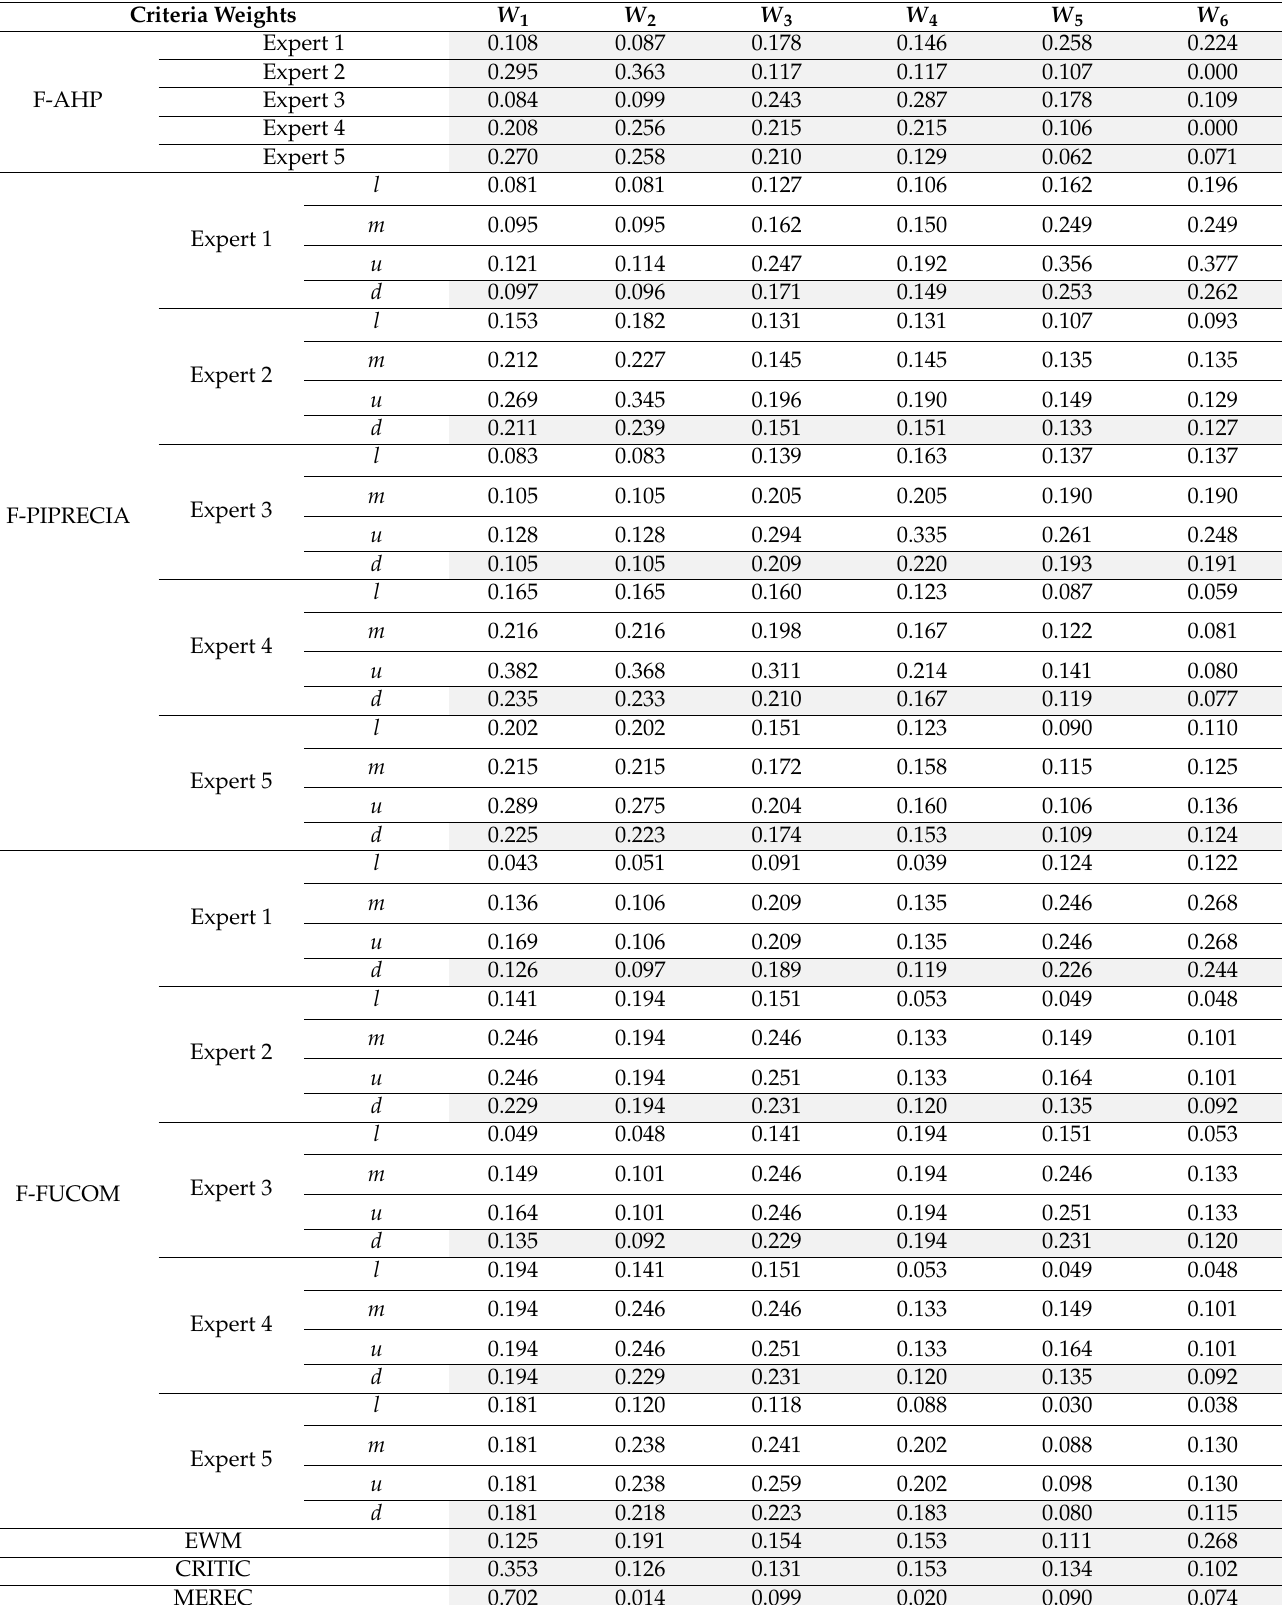
Table 4. Criteria weights of considered